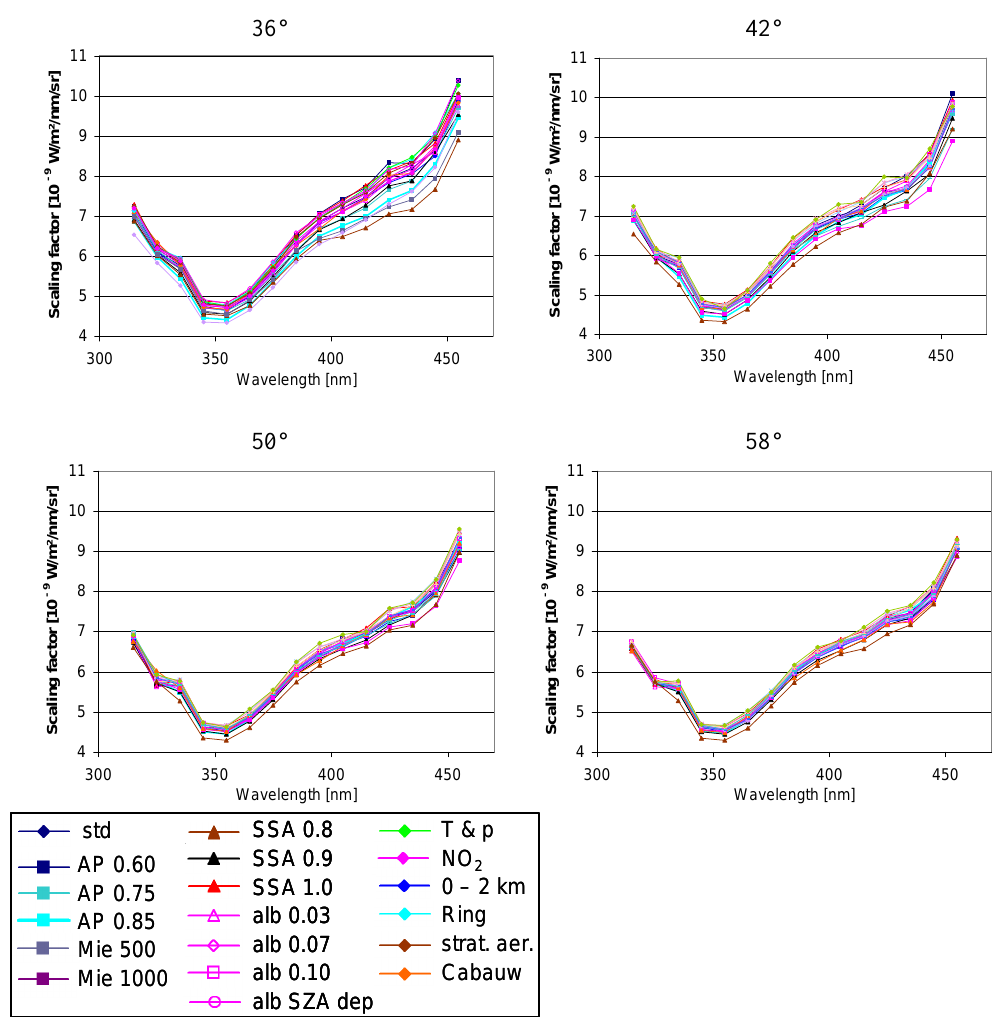
Figure 7. Derived scaling factors for different SZA intervals: the lower boundary of the SZA range is varied, while the upper boundary is always 90 ◦ . The different lines indicate the results for different scenarios (see Table